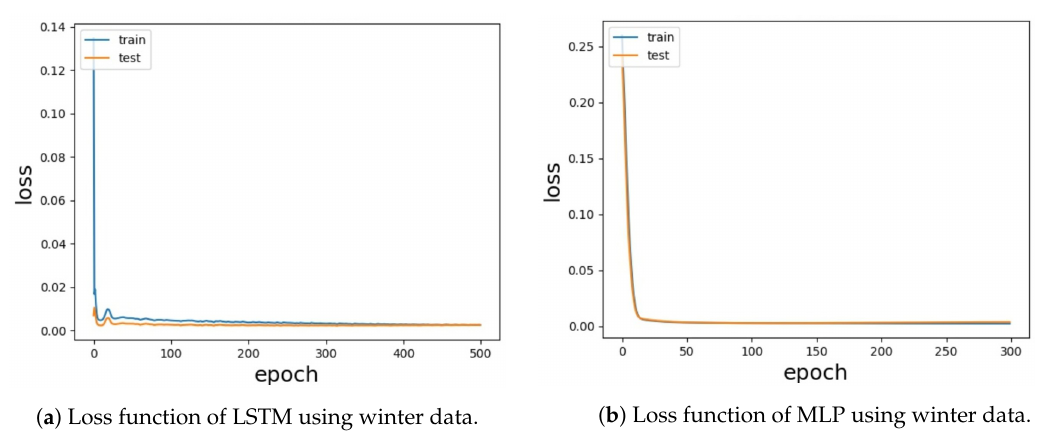
Figure 14. Loss function for SMP prediction with winter